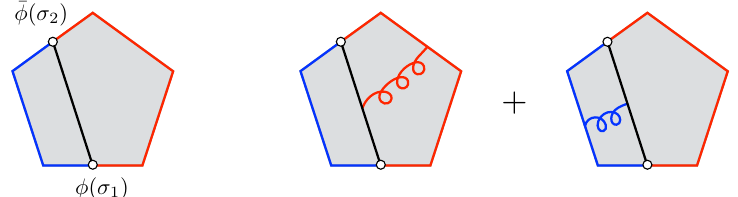
Figure 4 . Tree level representation of the pentagon transition for matter (cid:12)elds, here taken to be scalars, and its (cid:12)rst loop corrections. The two colors (red and blue) refer to the two gauge (cid:12)elds of the ABJM theory. Analyzing the (cid:12)rst loop corrections could help understanding how to upgrade pentagon transitions to higher